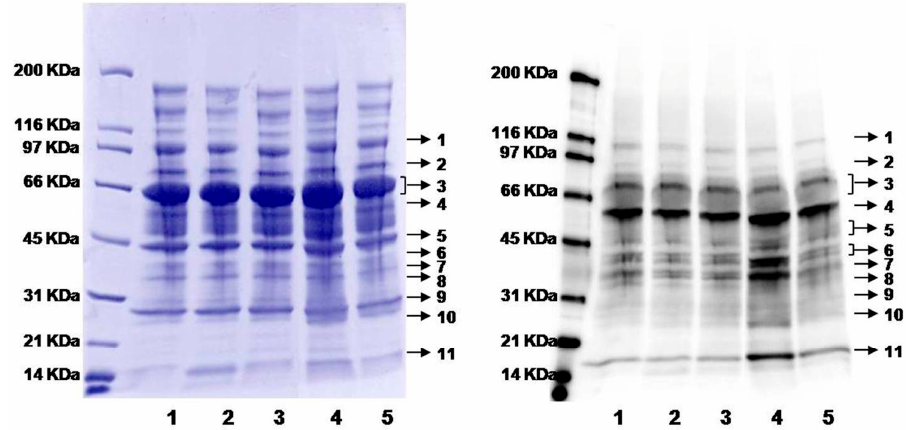
Figure 4. Gel images of plasma proteins from rats on B 12 -deficient and control diets. Left image: Coomassie blue staining showing total protein loading; right image: chemiluminescence from Western blotting showing the levels of biotin-labeling (protein N -homocysteinylation). Lanes 1, 2, and 3: plasma from individual rats on control diet; lanes 4 and 5: plasma from individual rats on a B 12 -deficient diet. Proteins were divided into eleven individual protein bands (indicated by the arrows) for subsequent analysis.